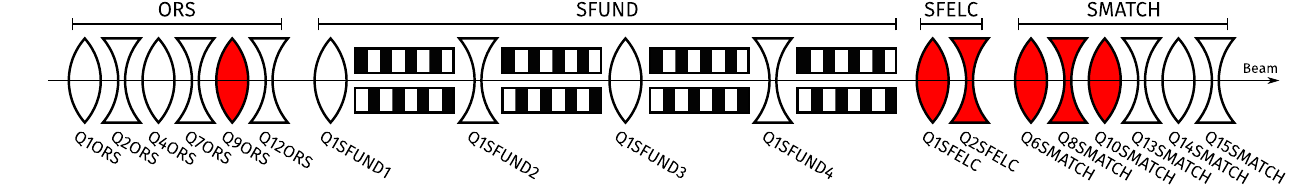
FIG. 4. Positions of the quadrupole magnets close to the sFLASH undulator. Note that the magnets in the SFUND section cannot be used as correctors. Magnets used in the example shown in Fig. 5 are highlighted in red. The drawing is not to scale.